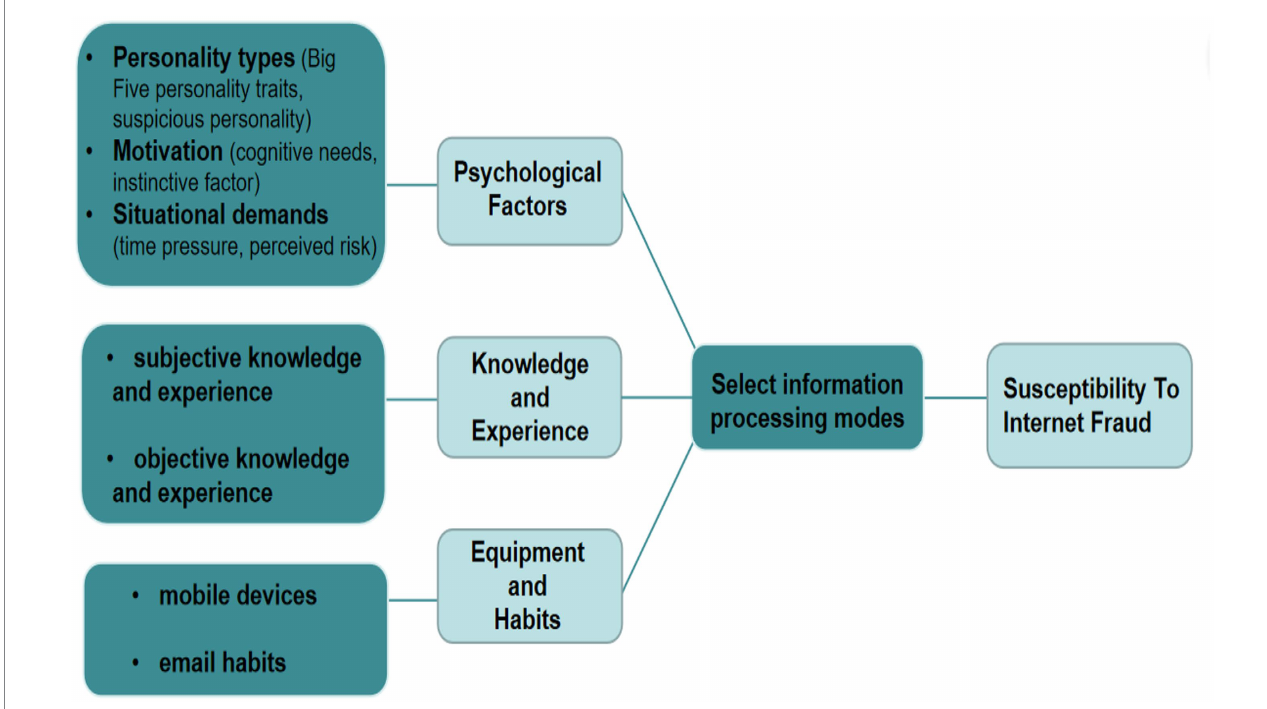
FIGURE 2 Influencing factors of susceptibility to internet fraud under a framework of the HSM (model drawing came from the author’s construction, and adapted from Wright and Marett, 2010; Norris et al.,